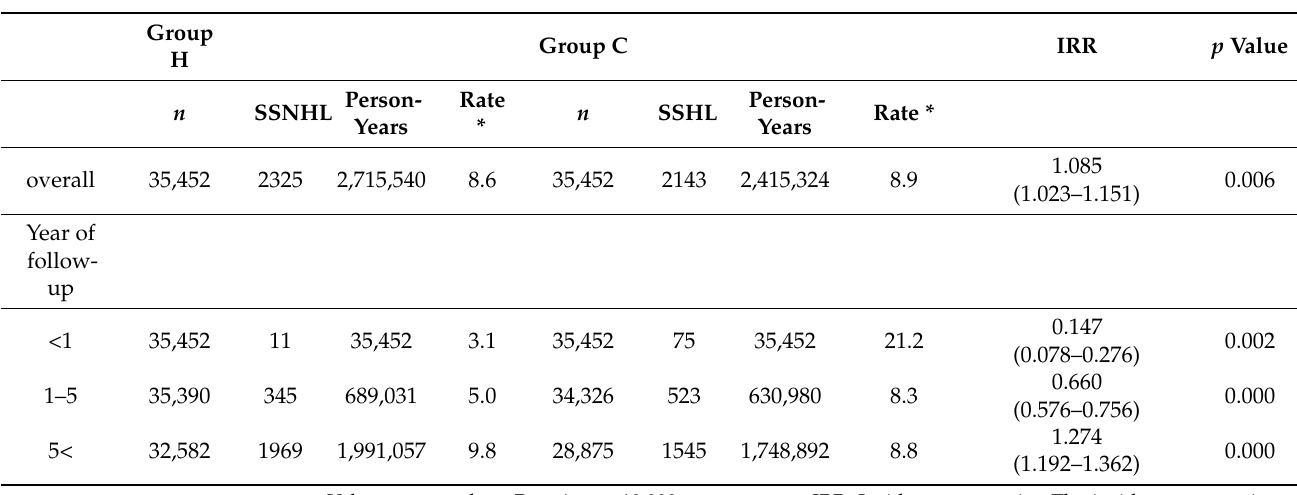
Table 3. Incidence of SSNHL according to follow-up period.